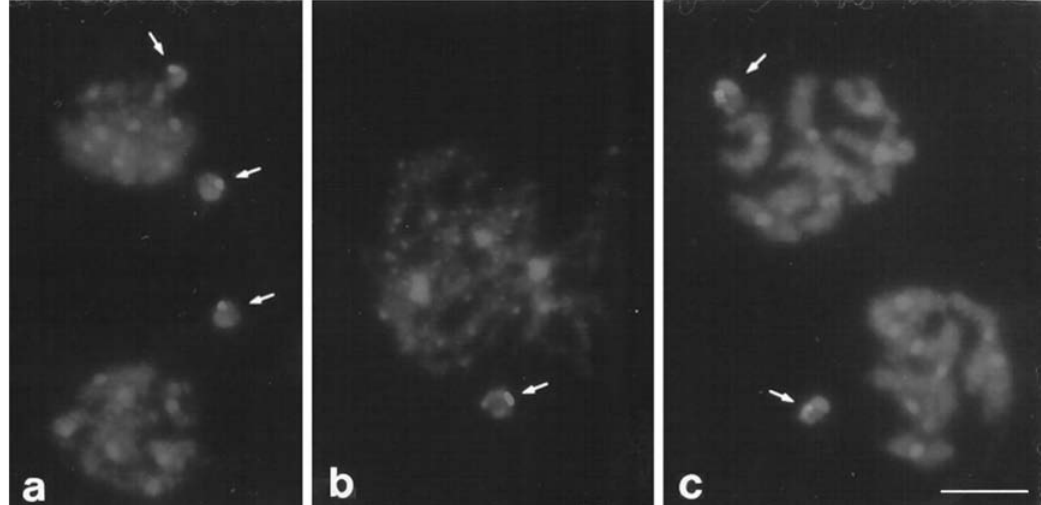
Figure 5 - Fluorescent in situ hybridization (FISH) in the three Rutelinae species. Zygotenes of G. borelli (a), P. pallidipennis (b) and M. festiva (c). Note the rDNA sites (arrows). Bar = 5 (cid:1)